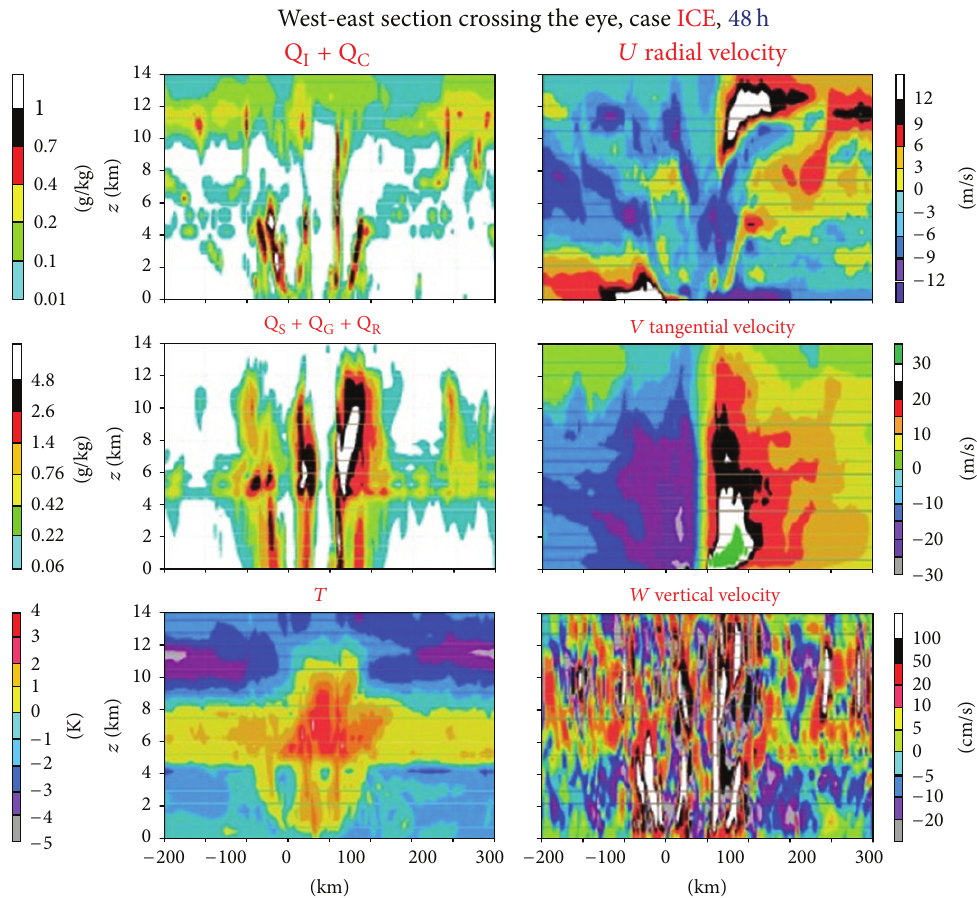
Figure 8: Vertical cross section (west-east section) of nonprecipitating substance, that of precipitating substance, temperature anomaly, radial velocity, tangential velocity, and vertical velocity at 48h in case ICE. The section crosses the center of the eye which is shown in the middle panel of Figure